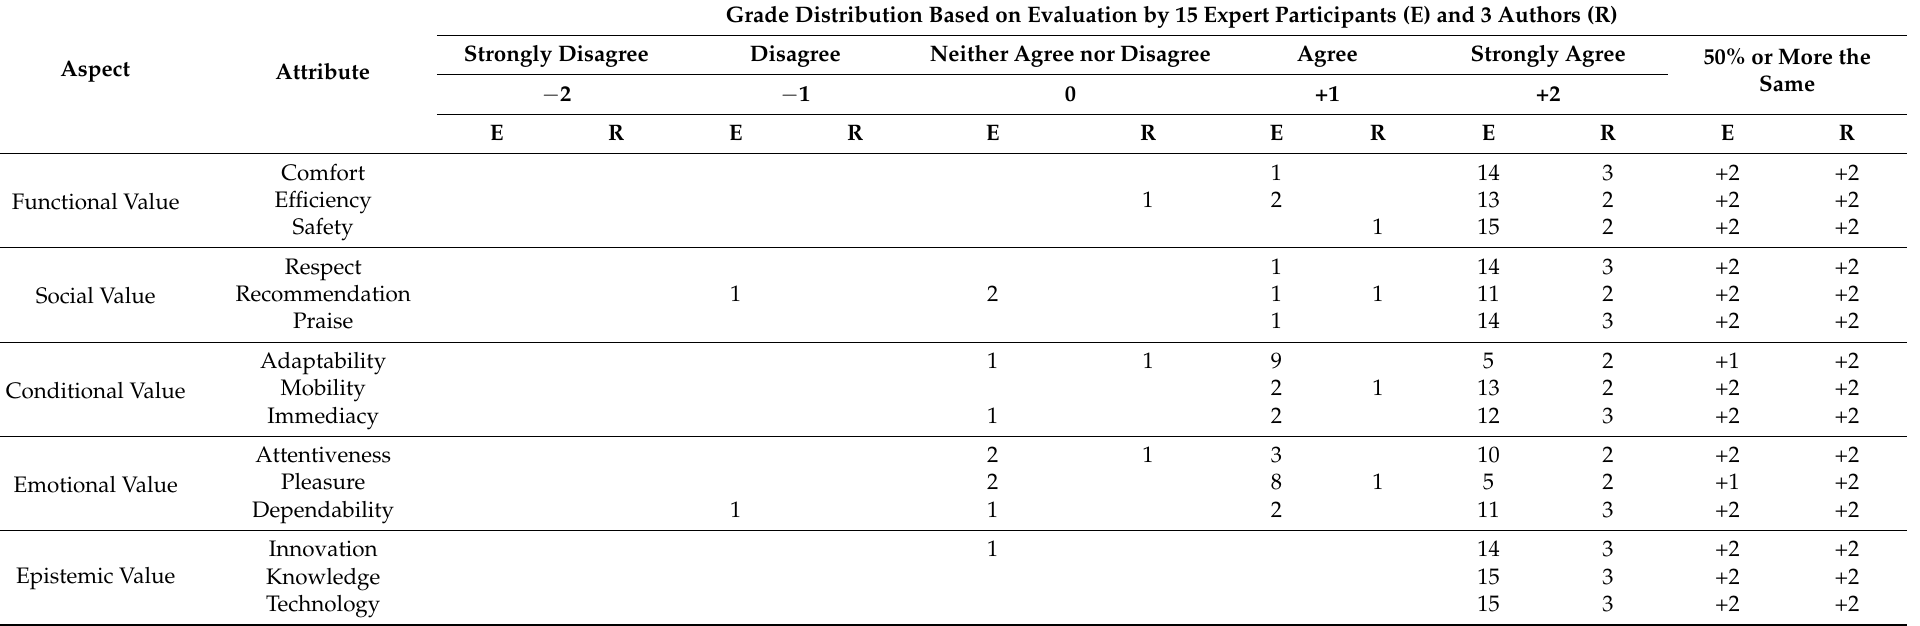
Table 6. Scoring based on content analysis of the CV-SQ attribute classification